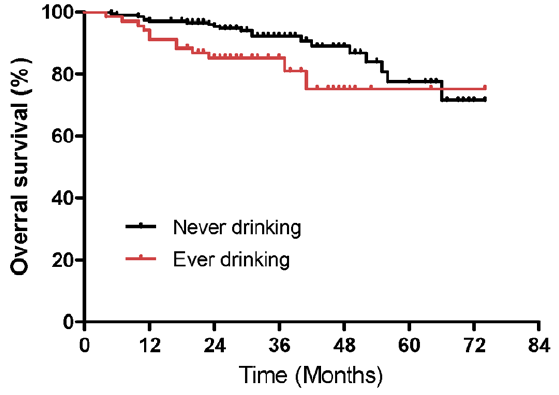
Figure 3. Kaplan-Meier estimates of overall survival of patients with alcohol drinking versus without alcohol